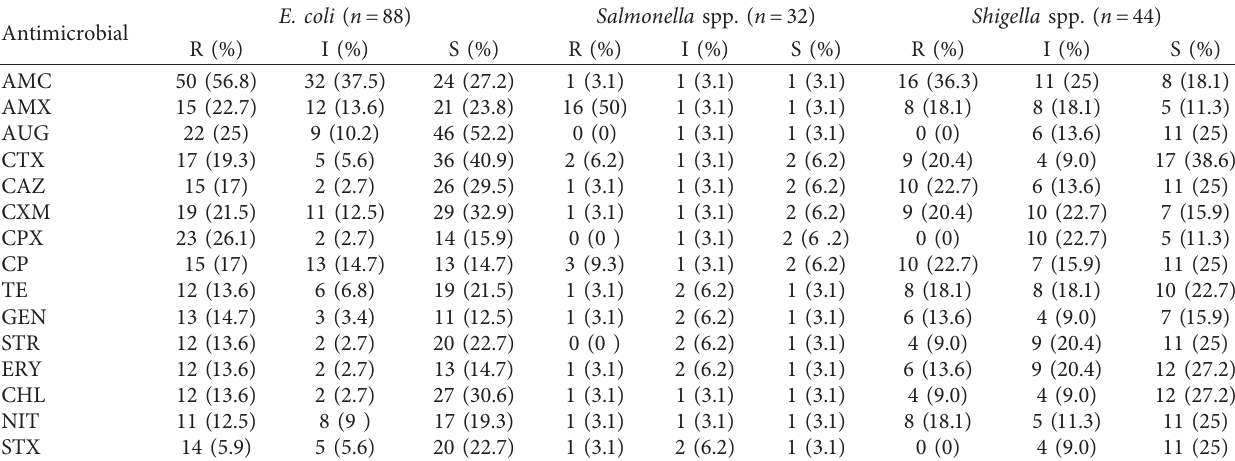
Table 2: Antibiotics sensitivity of Gram-negative bacterial isolates from teat milk samples, drinking water samples, and fecal swabs isolates from cattle’s and buffaloes. E. coli ( n � 88) Salmonella spp. ( n � 32) Shigella spp. ( n � Antimicrobial